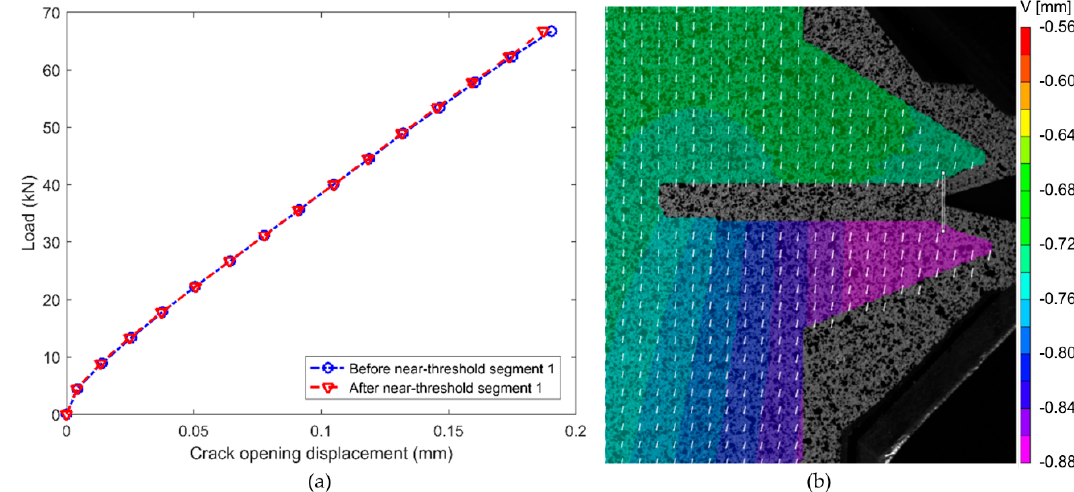
Figure 9. ( a ) Crack opening displacement before and after near-threshold loading cycles. ( b ) 3D-DIC displacement contour plot. White line with circular ends shows where crack mouth opening displacements (CMODs) were calculated and white arrows represent the displacement vector field.